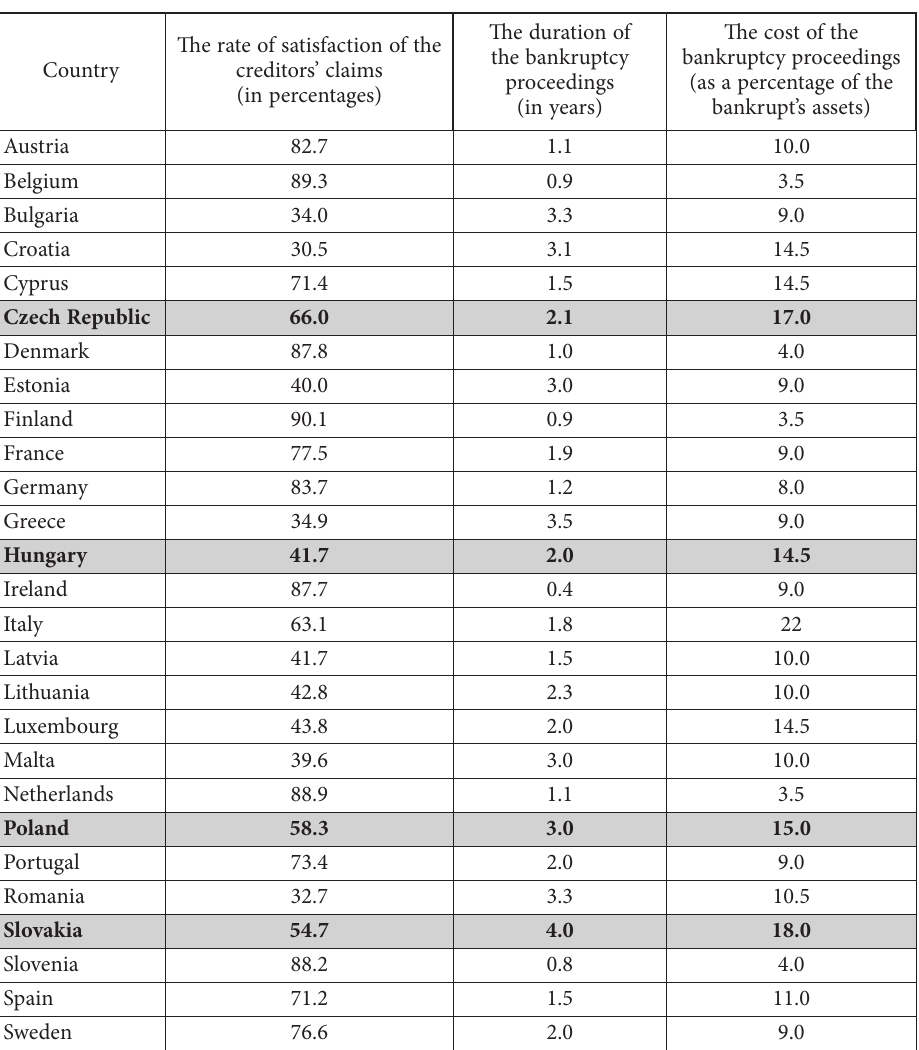
Table 8. The effectiveness of bankruptcy proceedings in the European Union countries in 2016 (source: Kupis, 2017)